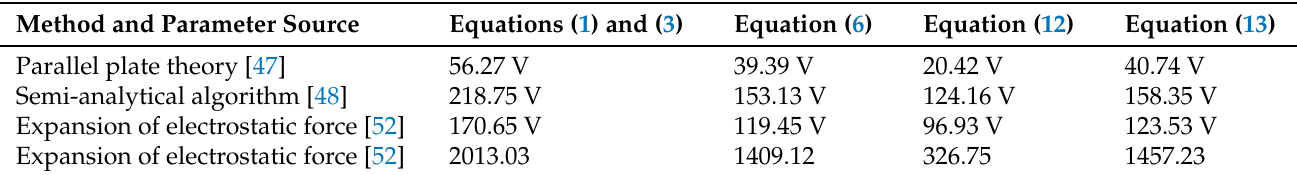
Table 2. Collapse voltages from different analytical